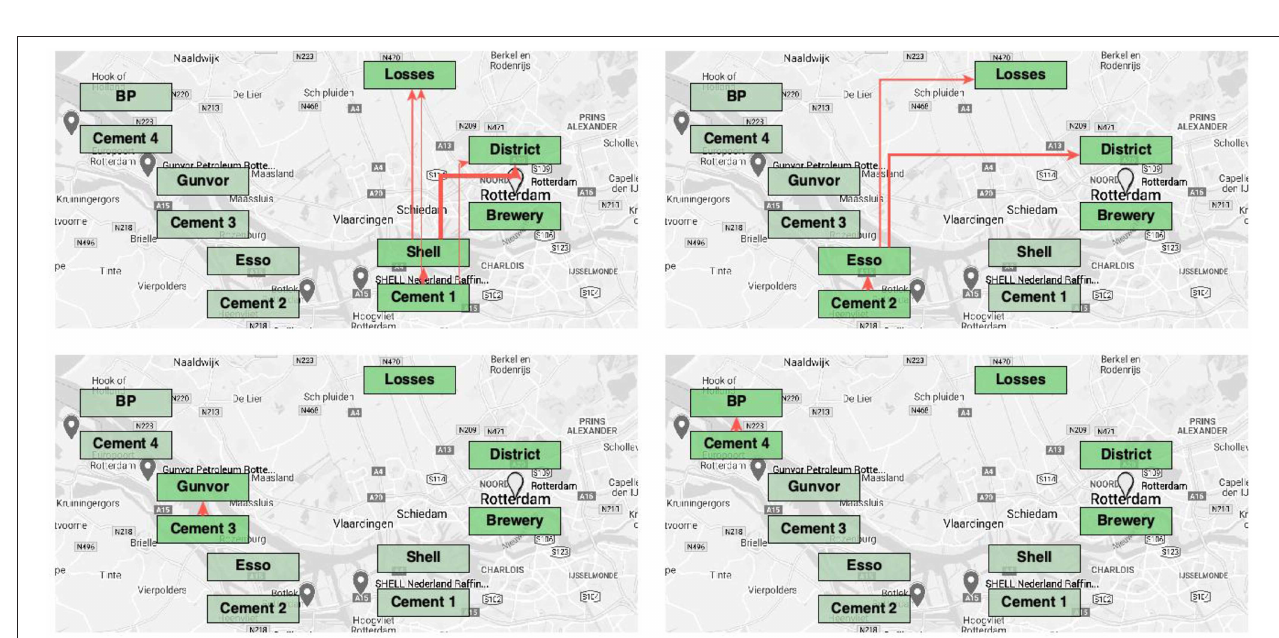
FIGURE 12 | Key performance indicators for operating cost and environmental impact ǫ -constraints.